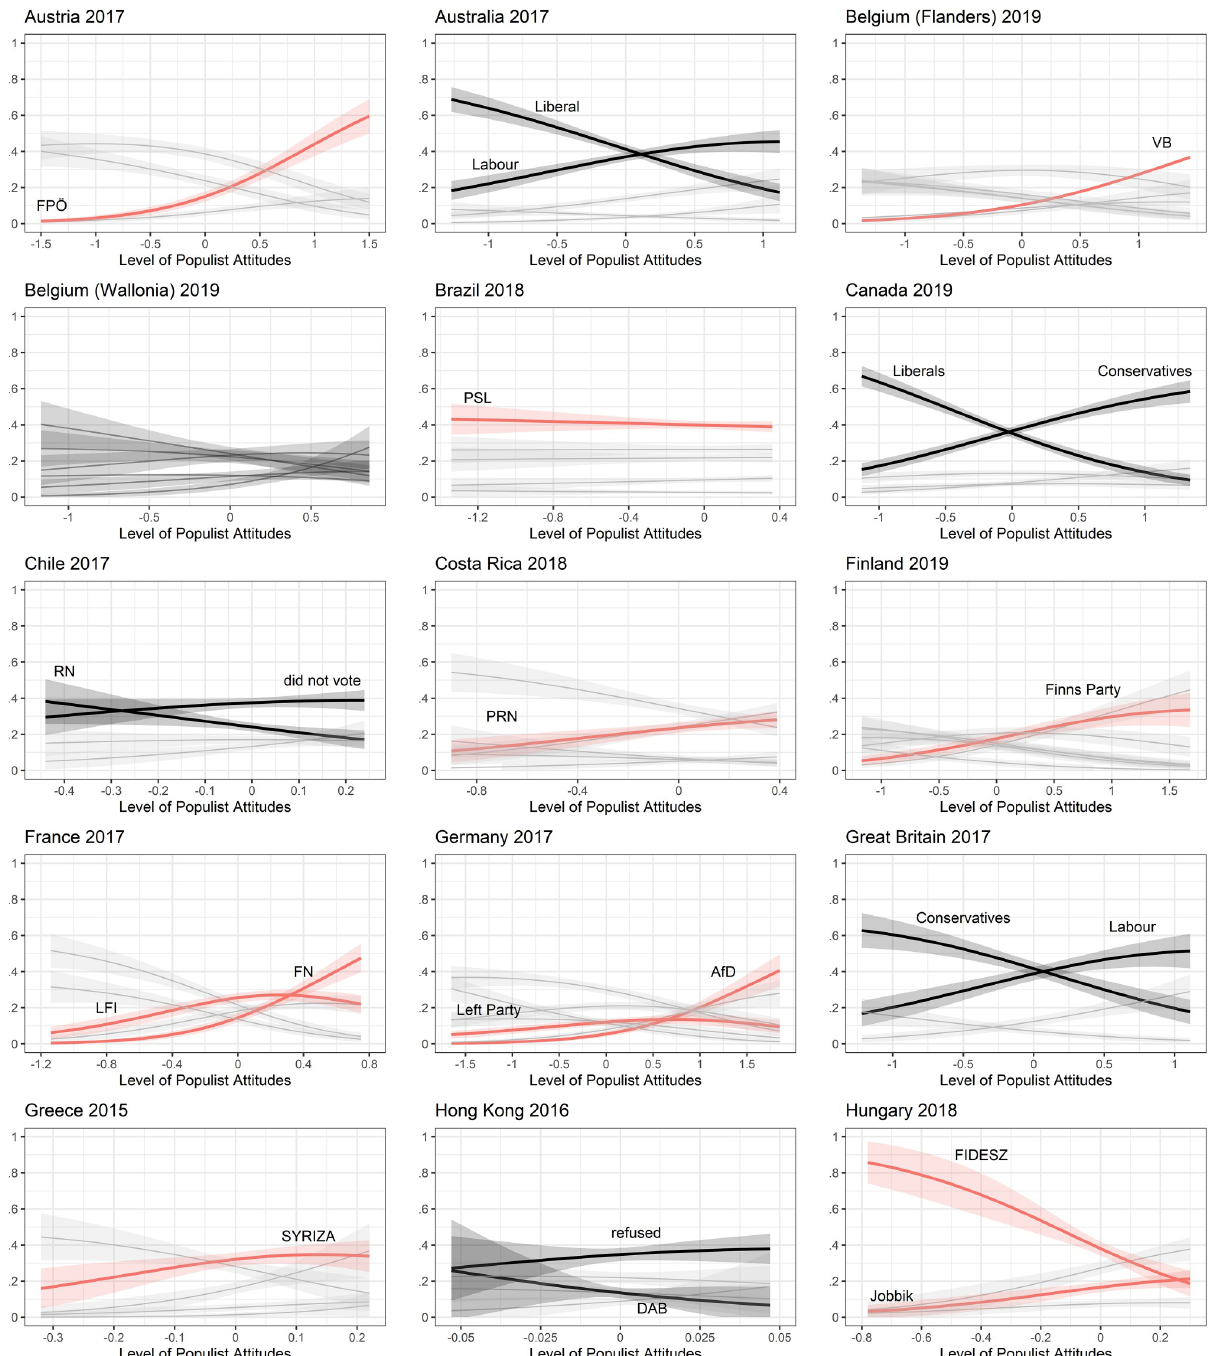
Fig 2. Predictions of populist vote across countries I. Predictions of vote choice are based on multinomial structural equation models with 95% confidence intervals.